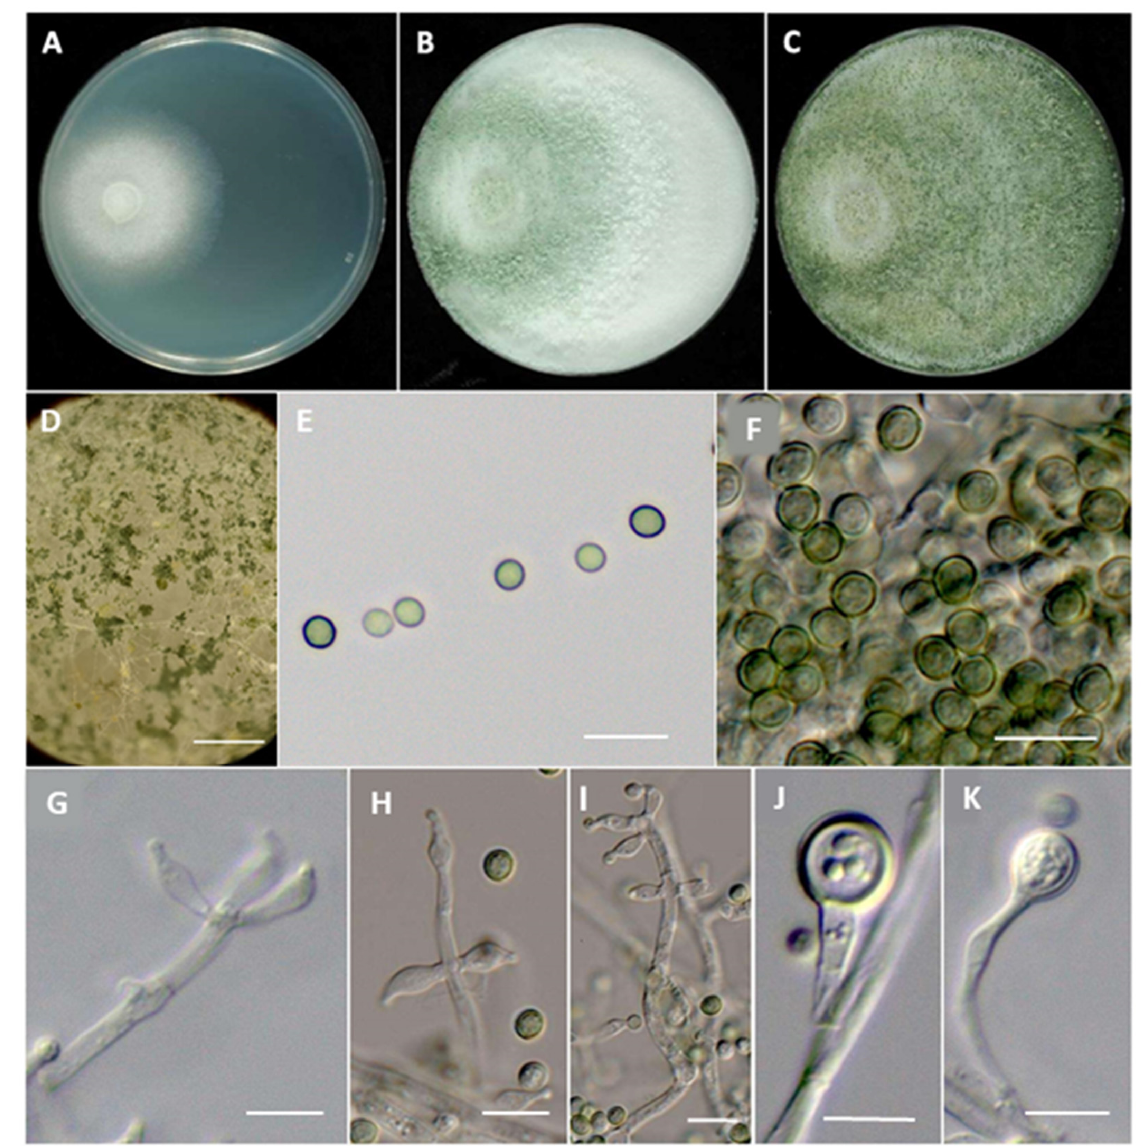
Figure 4. Trichoderma viticola SuRDC-1430. Cultures on PDA at ~22 °C after 3 d ( A ), 7 d ( B ), and 14 d ( C ). Conidiation pustules on PDA after 7 d ( D ), and 14 d ( E ). Single conidia ( F ) and mass conidia ( G ). Conidiophores and phialides ( H – J ). Chlamydospores ( K , L ). Scale bars represent 1 mm ( D ) and 10 µm ( E – K ).